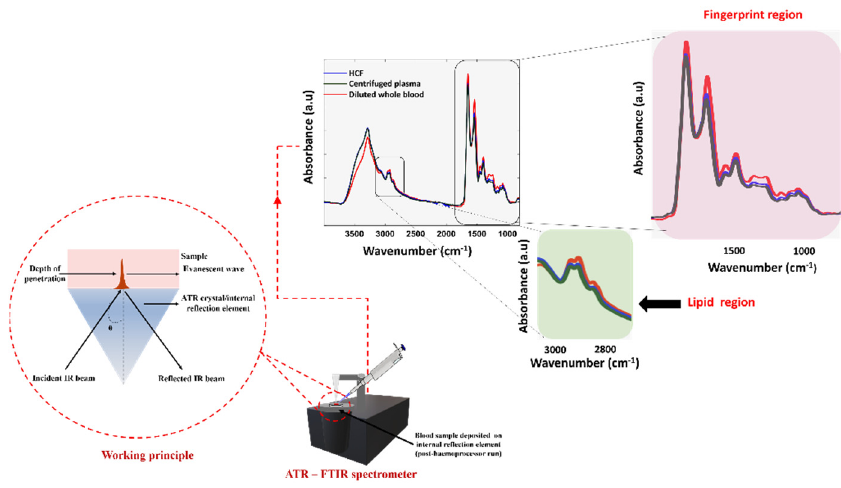
Figure 8. The ATR-FTIR measurements showing the raw spectrum of HCF, centrifuged plasma, and diluted whole-blood.